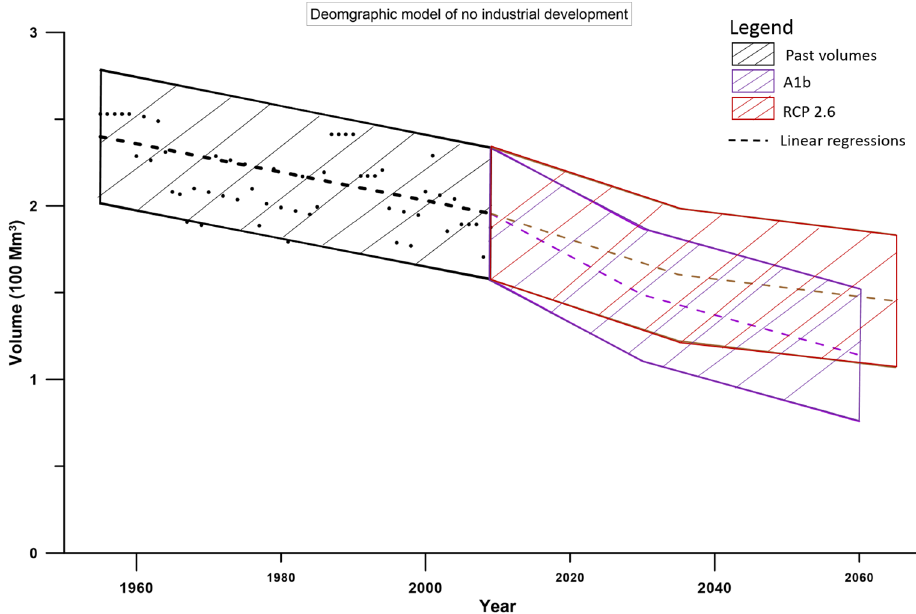
Figure 10. Graph, with the shaded areas representing the effective volume of Shela aquifer and projected volumes for A1b and RCP 2.6 climate change scenarios, as well as the uncertainties for the demographic model without the port (“no industrial development”).